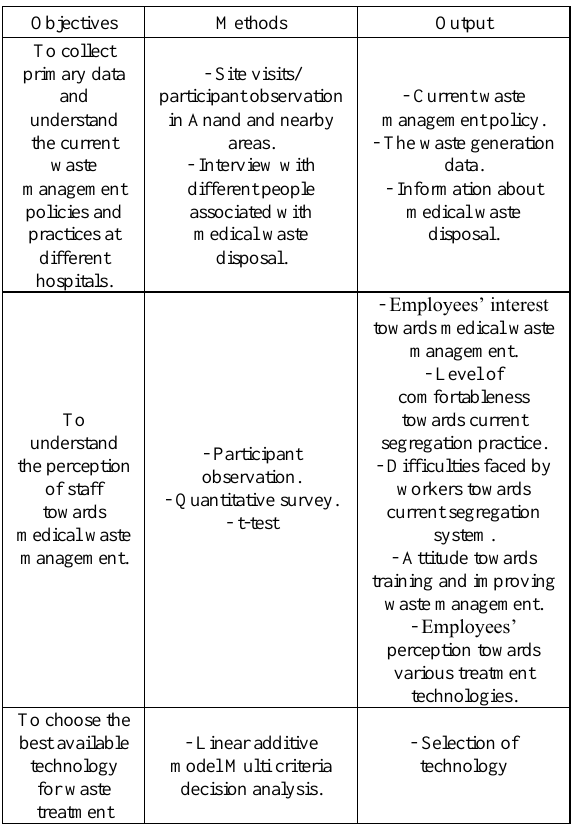
Table 1. Methods adopted for the